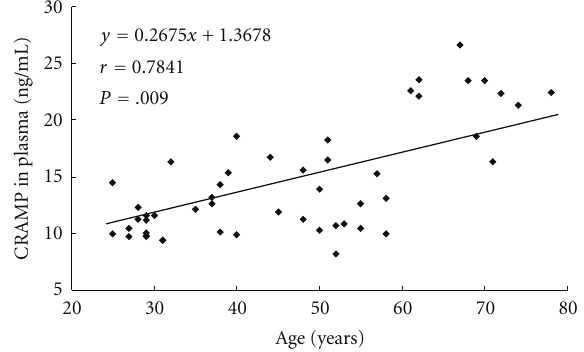
Figure 2: Evaluation of CRAMP in healthy people. In blood plasma, the expression levels of CRAMP increases during human aging.